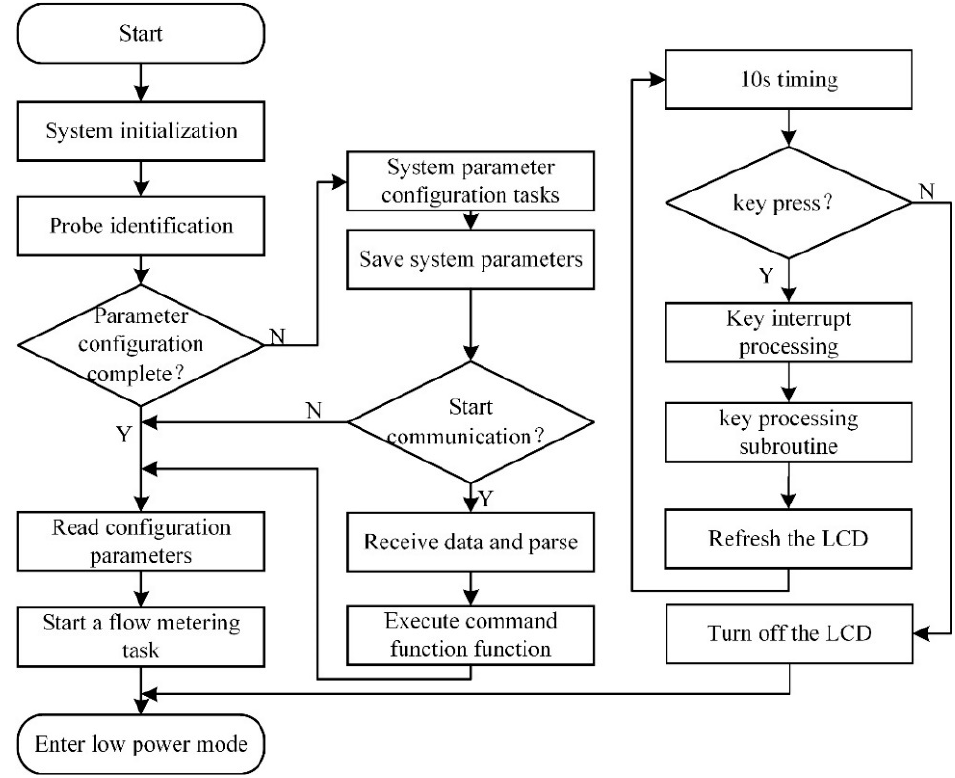
Figure 15. Flow chart of system function switching and parameter configuration module.